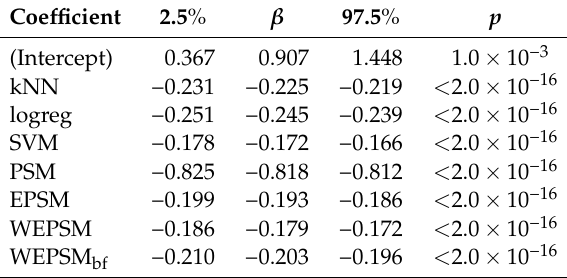
Table 4. GLMM (Generalised Linear Mixed Effects Model) estimates ( β ), 95% confidence intervals, and p -values of the fixed effects on subject-independent performance associated with learning algorithms and personalisation–generalisation